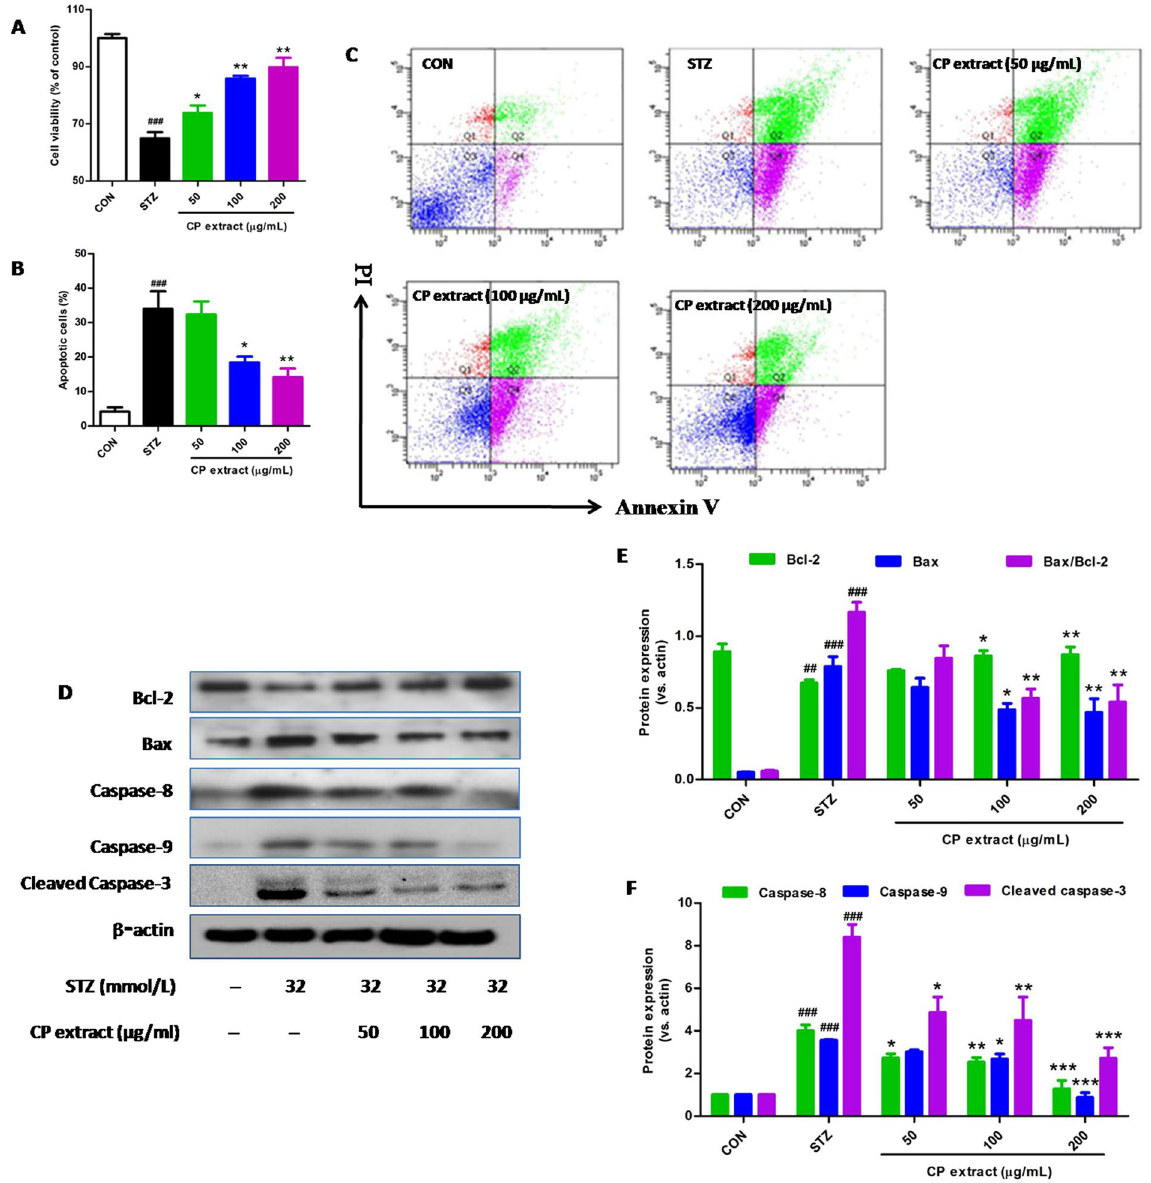
Figure 6. CP extract prevents STZ-induced pancreatic β cell apoptosis in NIT-1 cells. NIT-1 cells were preincubated with CP extract (50, 100 and 200 μ g/mL) for 2 h before 32 mM STZ treated for 24 h. (A) Cell viability was assessed by MTT assay. ( B and C ) The apoptotic cells were stained with annexin V-FITC and PI, and then detected by flow cytometry. ( D – F ) Cells were lysed and then the expression of Bcl-2, Bax, caspase-8, Caspase-9 and cleaved caspase-3 were measured using Western blot. Data were expressed as mean ± SEM from three independent experiments. ### p < 0.001, compared with untreated control group; * p < 0.05, compared with STZ-treated